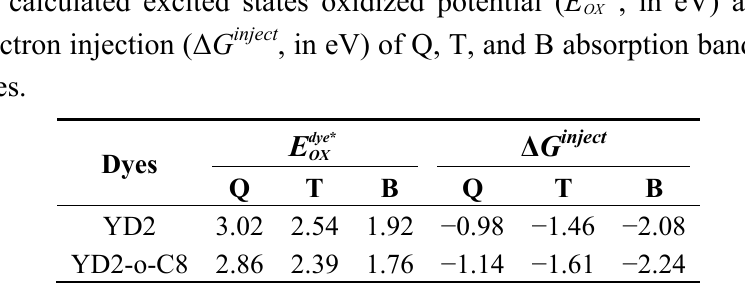
, in eV) and free energy OX